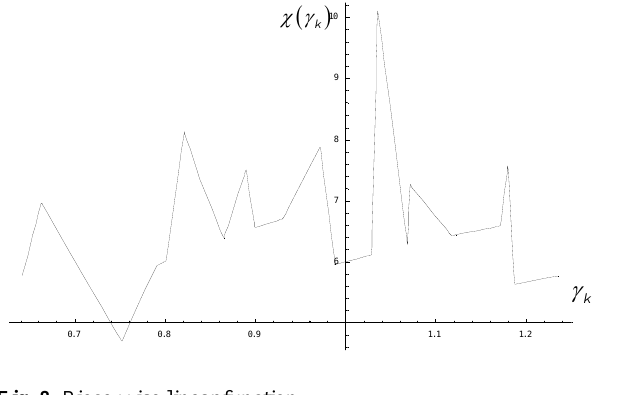
Fig. 8. Piece-wise linear function χ .